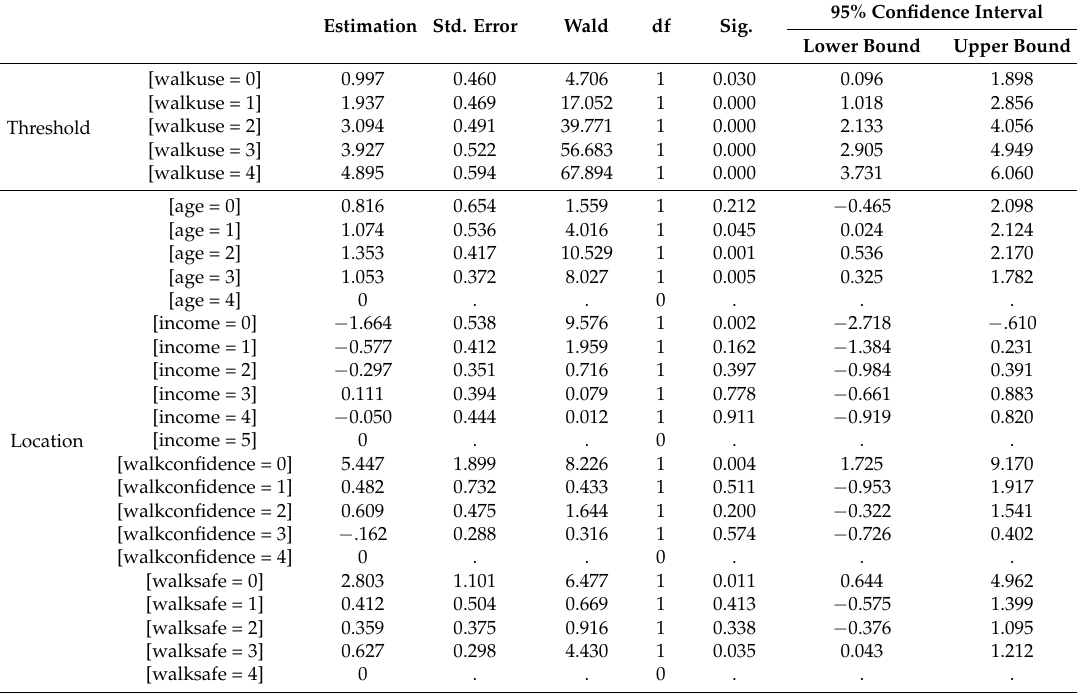
Table A5. Parameter Estimates for the walking model. Estimation Std. Error